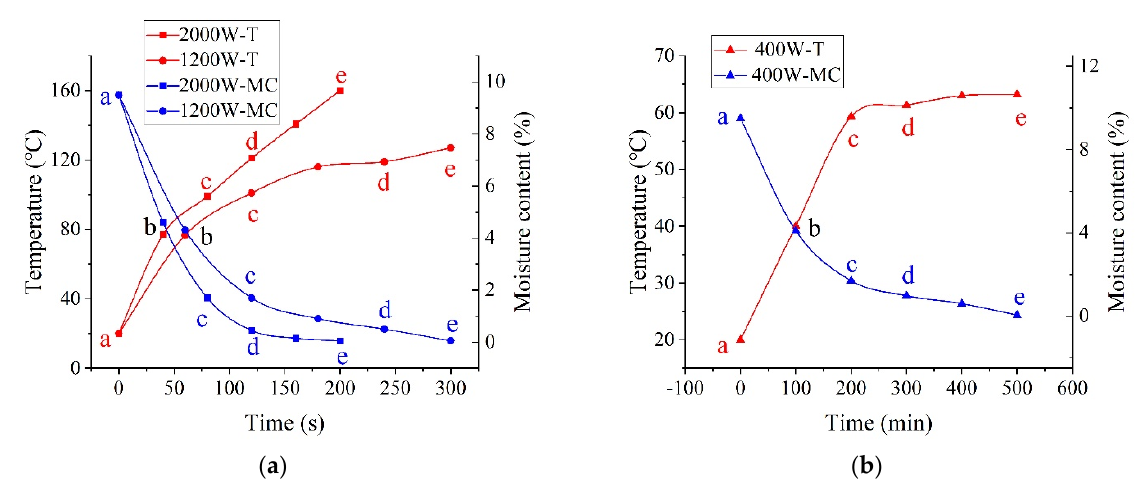
Figure 5. Variations of moisture content and temperature versus time. ( a ) is the relationship between the temperature and moisture content of the material with the curing time under the curing conditions of 1200 W and 2000 W. ( b ) is the relationship between the temperature and moisture content of the material with the curing time under the curing conditions of 400W.